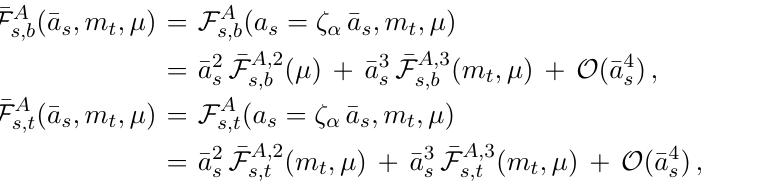
( x ) plotted as function of x = s/m 2 s,t ≈ − 5 . 94 [3, 26, s,b